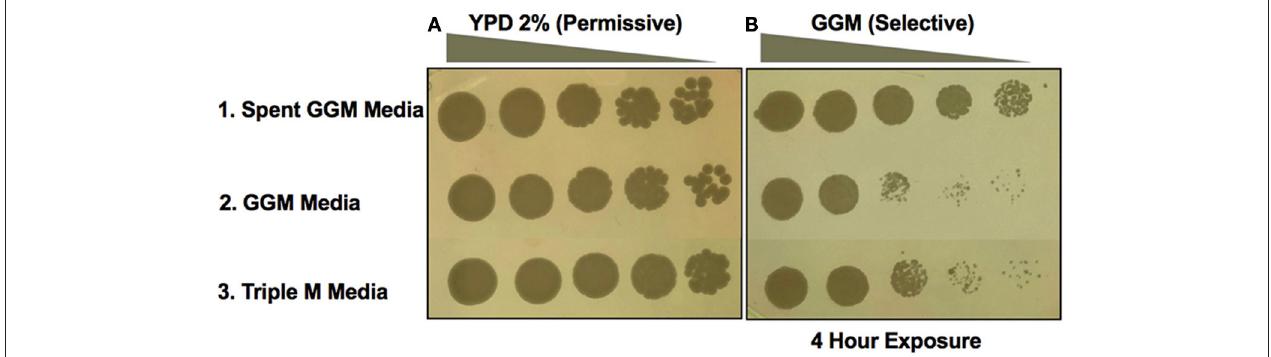
FIGURE 5 | Bacterial spent media induction of [ GAR + ] in Saccharomyces . Growth of UCD932 in different conditions on the control media, YP with 2% glucose (A) . Growth following exposure to Acetobacter pasteurianus (UCD175) spent GGM media for 4 h compared to growth in control media or synthetic grape juice (Triple